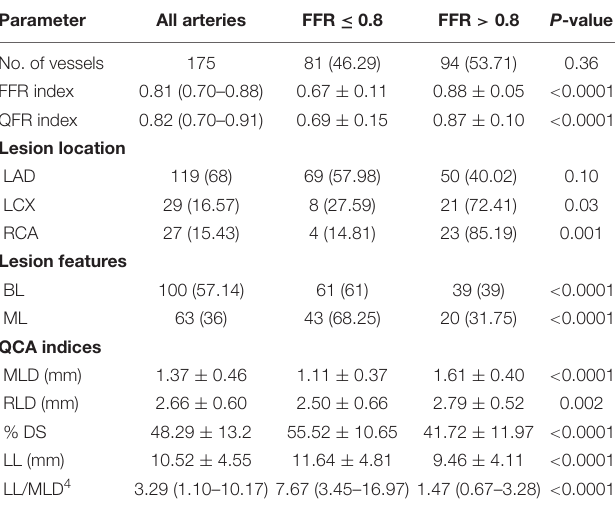
TABLE 2 | Angiographic and FFR findings ( n = 175).